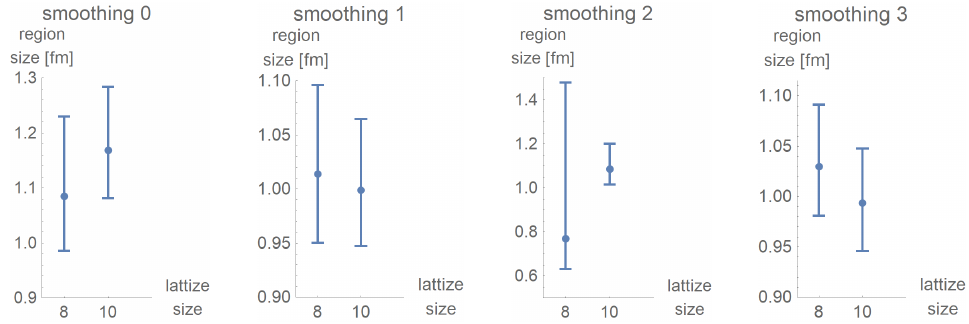
Figure 15. Estimated size of color-homogeneous regions after three cooling